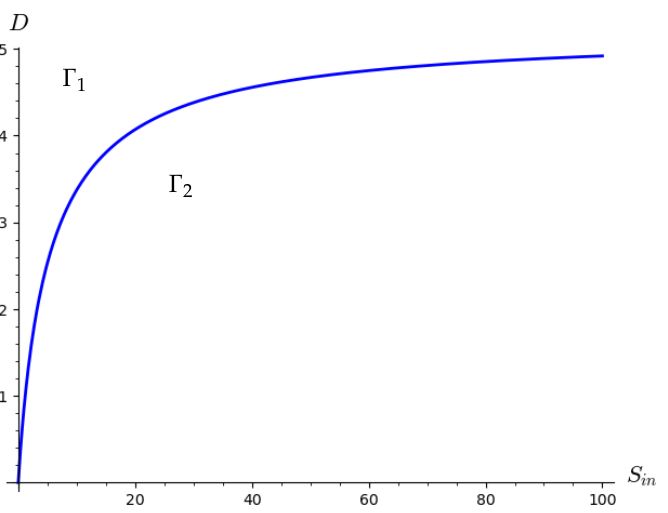
Figure 4. Phase portrait of aggregated model. ( a ) Parameter set: D = 0.05, S in = 10; µ = 0.03; u = 0.3; k = 0.5. ( b ) Parameter set: D : 0.2, S in = 10; µ = 0.22; u = 0.3; k = 0.5.